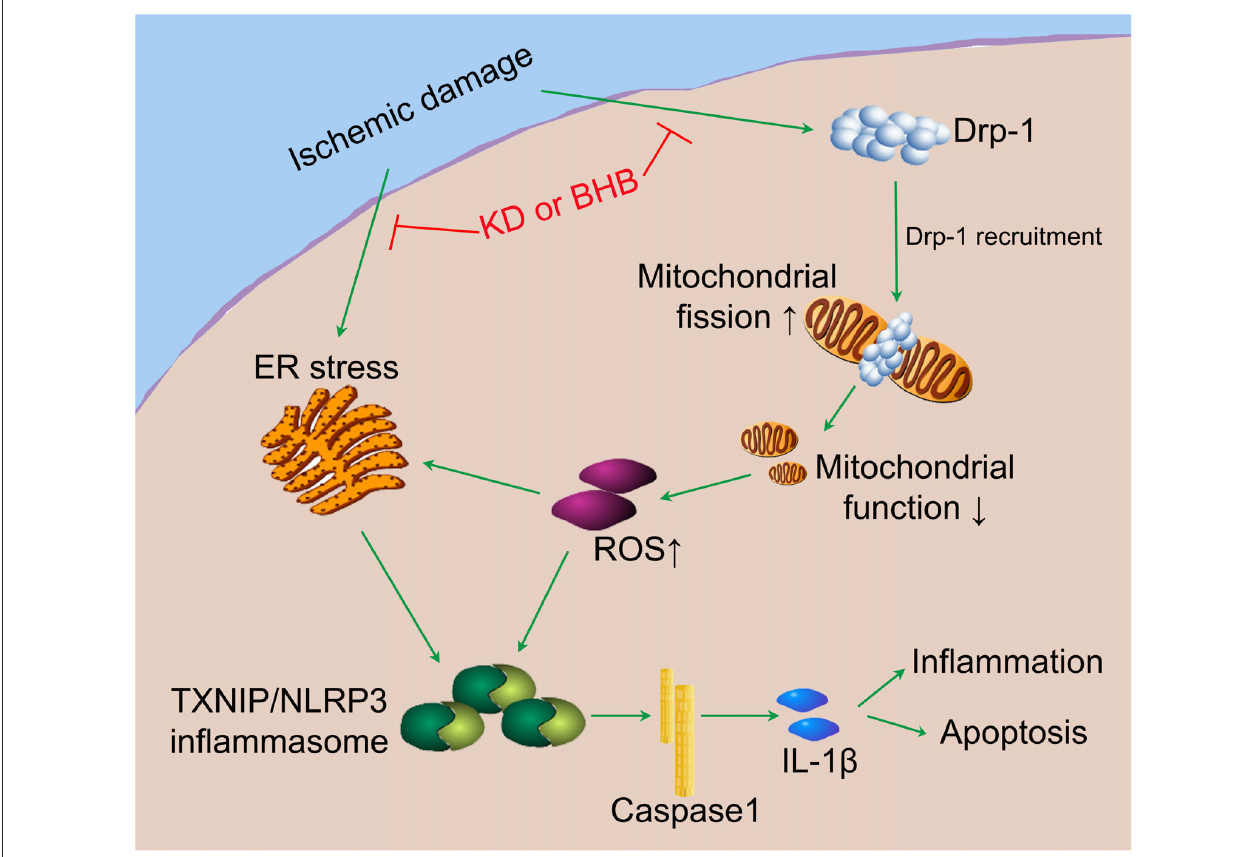
FIGURE 10 | The potential mechanistic pathway by which KD or BHB regulates NLRP3 inflammasome activation. Ischemic damage causes Drp1-mediated mitochondrial fission and ER stress. Excessive ROS production aggravates ER stress and induces TXNIP/NLRP3 activation. The resultant maturation of IL-1 β is responsible for the inflammation and cell apoptosis, leading to the central nervous system dysfunction. KD or BHB suppresses Drp1 recruitment and ER stress, thereby alleviating inflammation and improving brain ischemic injury.